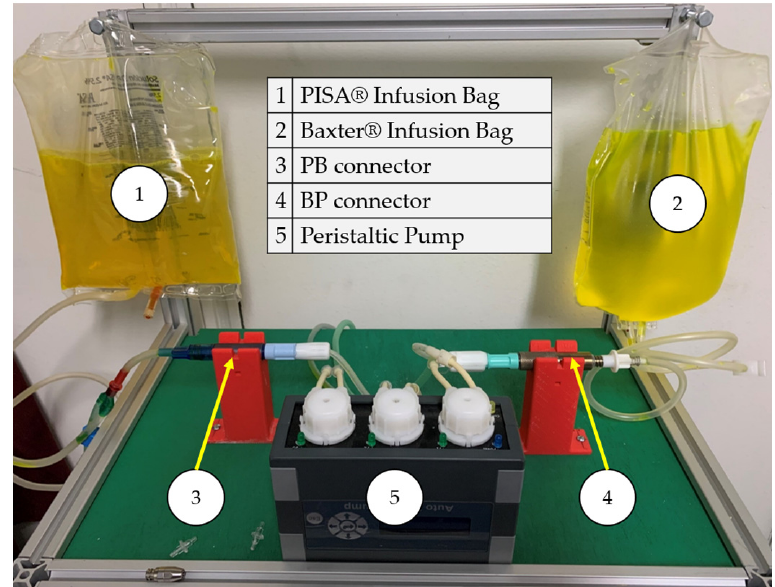
Figure 11. Leak experimental bench for BP and PB connectors.